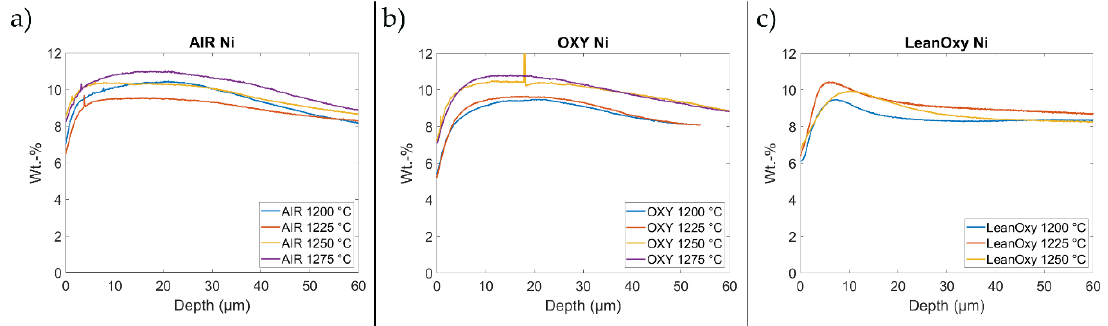
Figure 8. The individual temperature GDOES graphs for Ni in ( a ) air, ( b ) oxyfuel and ( c ) lean oxyfuel atmosphere. The individual Si GDOES depth profiles for air (a) and oxyfuel (b) atmospheres can be seen in Figure 9. Differences within a single atmosphere were limited to between 0 and 30 μ m. For the air atmosphere, the highest Si value was at 1250 °C at the original sample surface with 2 wt. %. The highest Si value for oxyfuel atmosphere was at 1225 °C near 3 wt. %. The other Si peaks fell between 1.2 and 1.4 wt. % for both atmospheres.